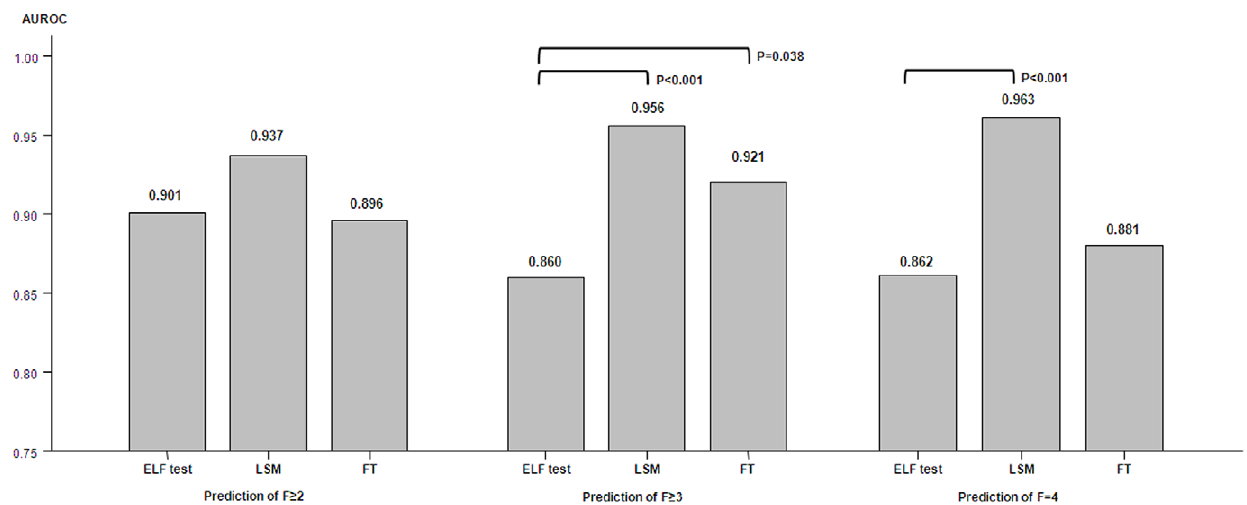
Figure 4. Detailed AUROCs of ELF test, LSM and FT in the diagnosis of significant fibrosis ( $ F2), advanced fibrosis ( $ F3), and cirrhosis